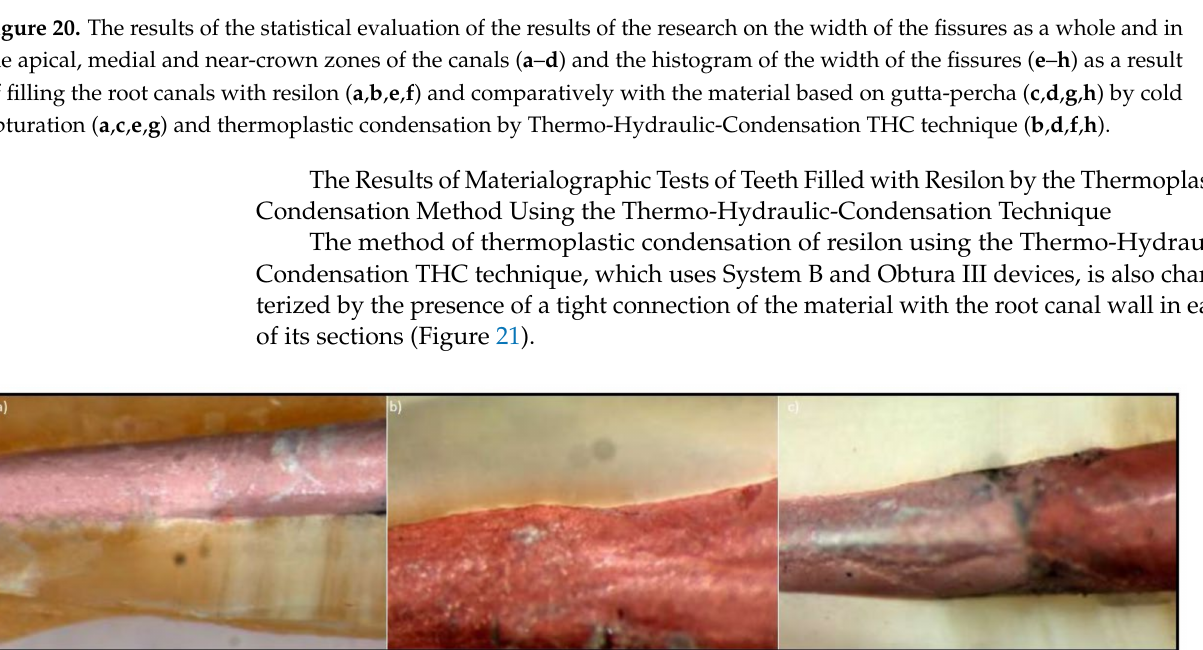
Figure 21. Borderline of tight connection of the root canal wall, the intermediate layer of sealant and resilon as a filling material using thermoplastic condensation using the THC technique (LSM): ( a ) in the middle part of the root canal; ( b ) in the near-crown part of the root canal; ( c ) linear connection of the main cone with the complementary material, bonded with a thin layer of sealant and covered with a thin layer of sealant in the middle part of the root